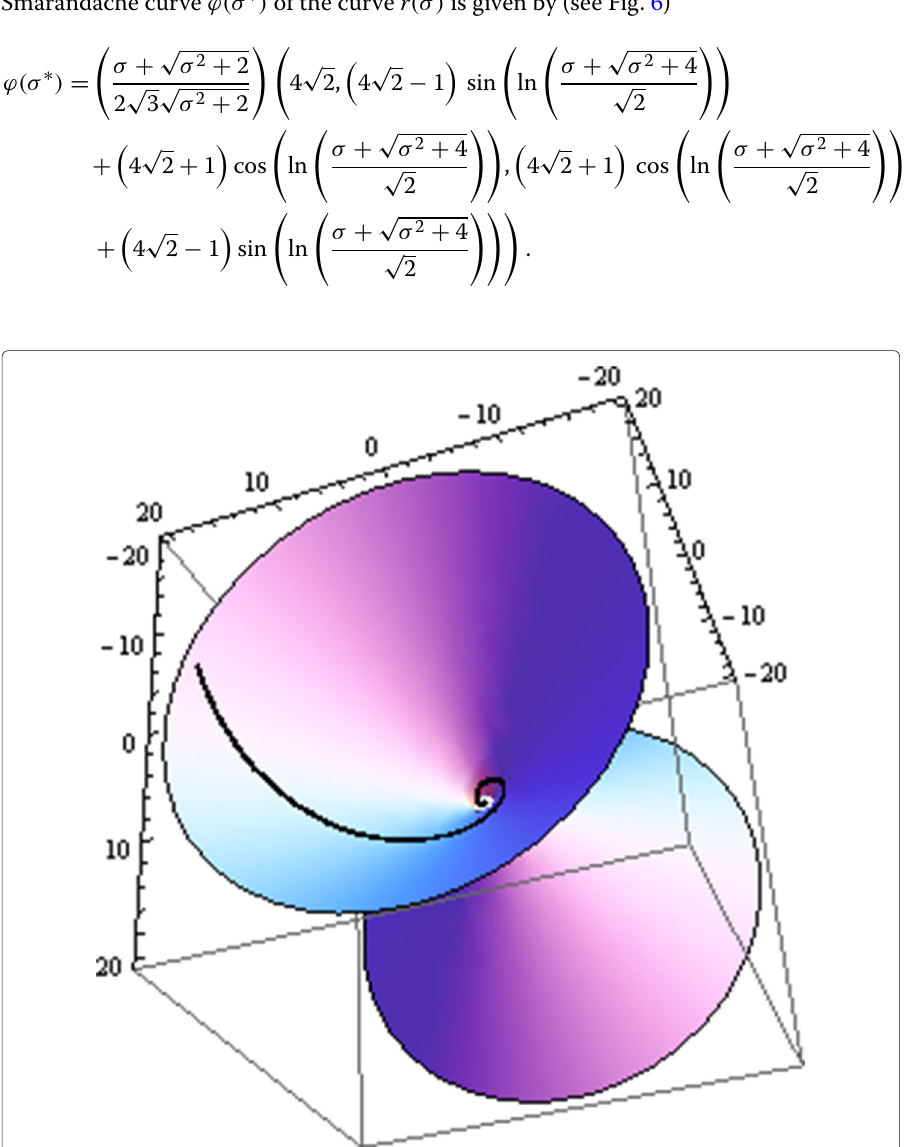
Fig. 5 The spacelike equiform-Bishop B 1 B 2 -Smarandache curve ϕ(σ ∗ ) on S 2